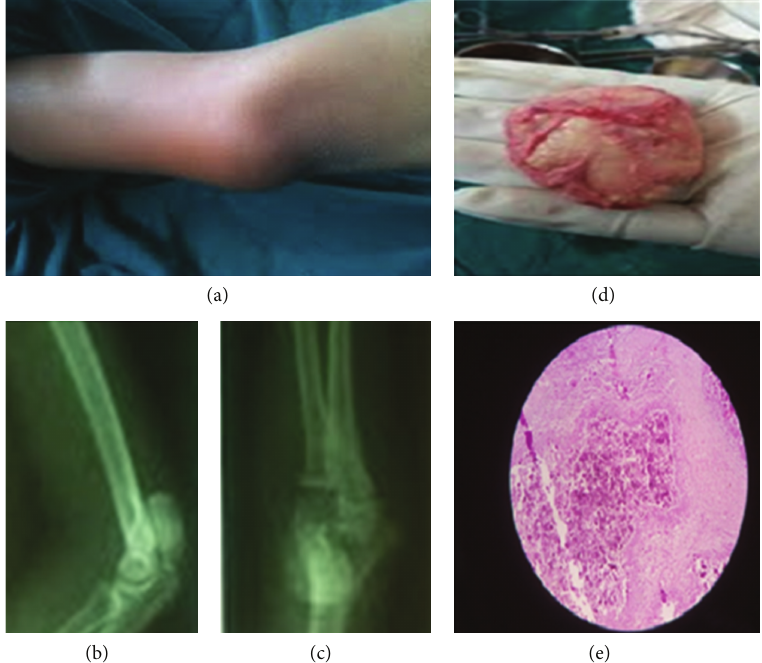
Figure 1: (a) Clinical picture of elbow with swelling and erythema; (b) and (c) X-ray of elbow AP and lateral views showing calcified mass over distal end of humerus; (d) gross morphology of excised specimen; (e) microscopic picture showing homogenous calcified mass with fibrous septa with giant cells and macrophages